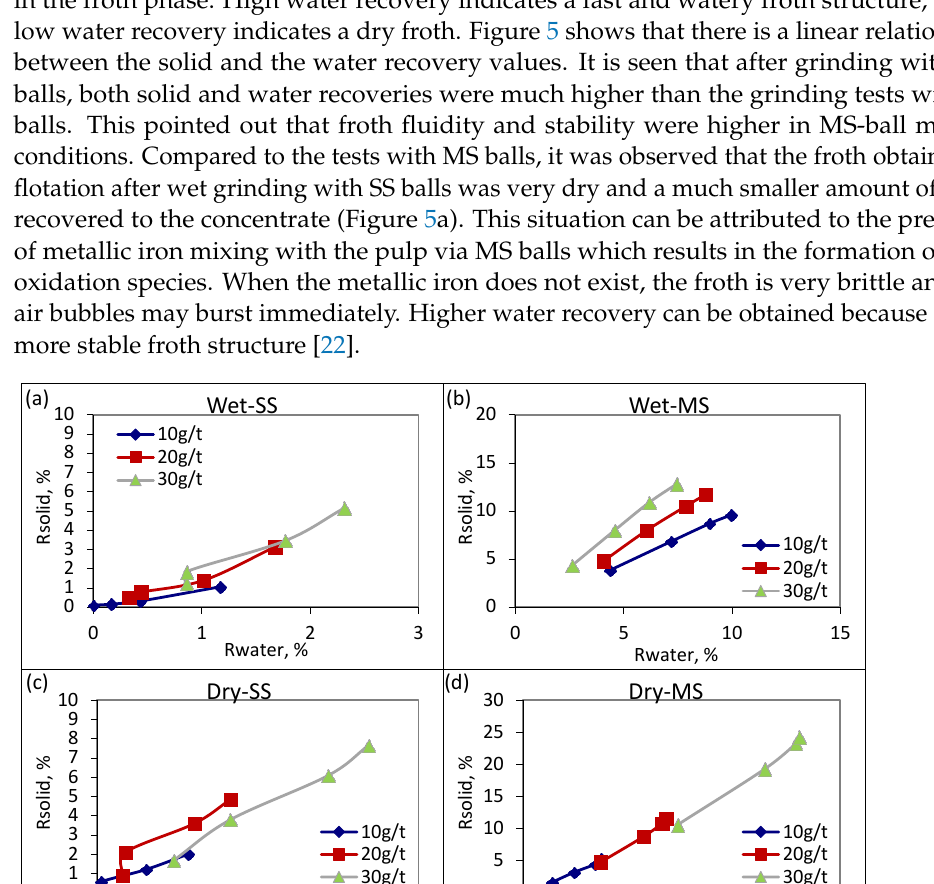
Figure 4. The relationship between DO concentration and flotation rate of Cu after different milling conditions.